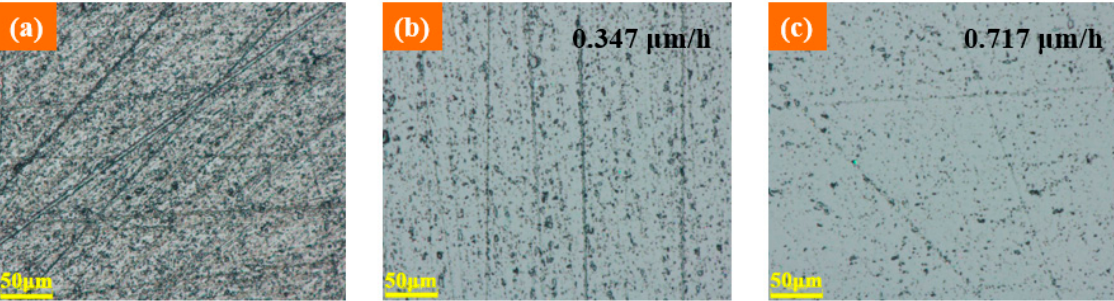
Figure 4. Influence of ultrasonic vibration on CMP: ( a ) optical image after common lapping; ( b ) optical image after common CMP after common lapping; ( c ) optical image after ultrasonic CMP after common lapping.